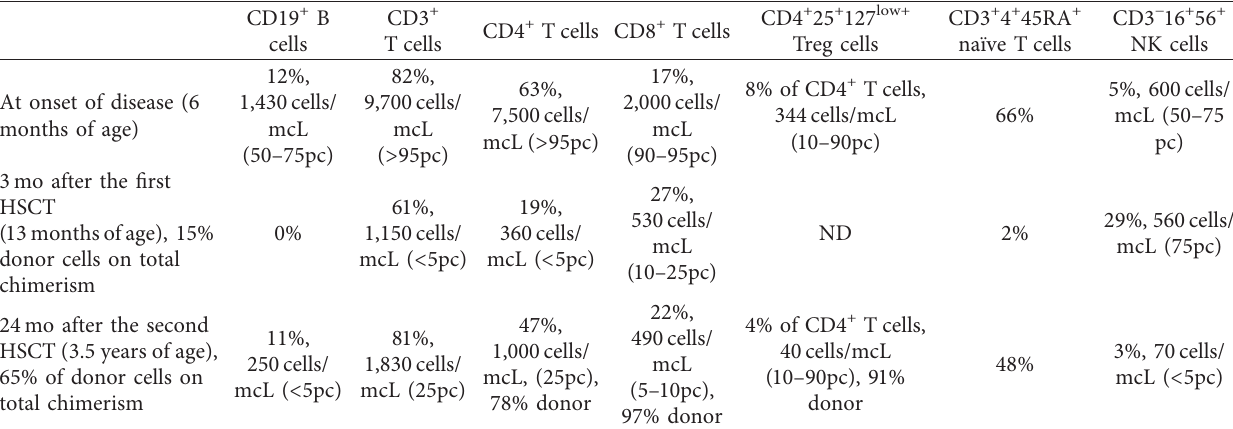
Figure 1: FOXP3 expression in Treg cells measured by flow cytometry: (a) control; (b) patient. Table 2: Lymphocyte subsets before and after the hematopoietic stem cell transplant